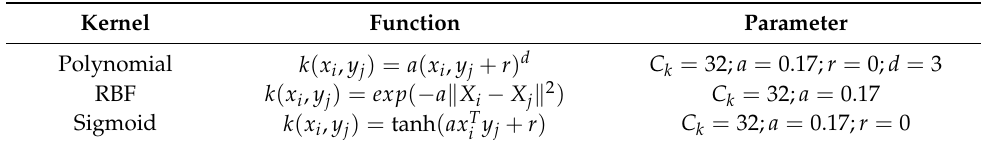
Table 2. Support Vector Machine (SVM) Kernel functions and parameters. Kernel Function Parameter